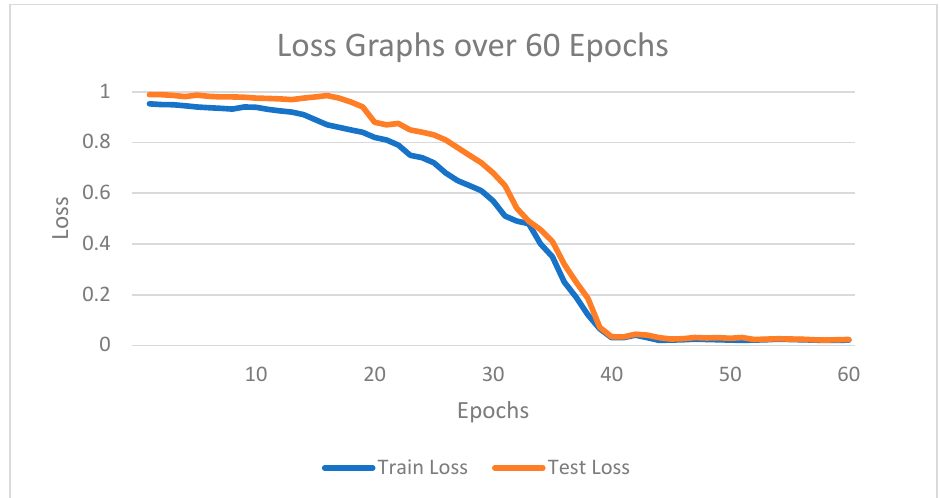
Figure 3. Loss graph of proposed deep learning model with respect to epochs.